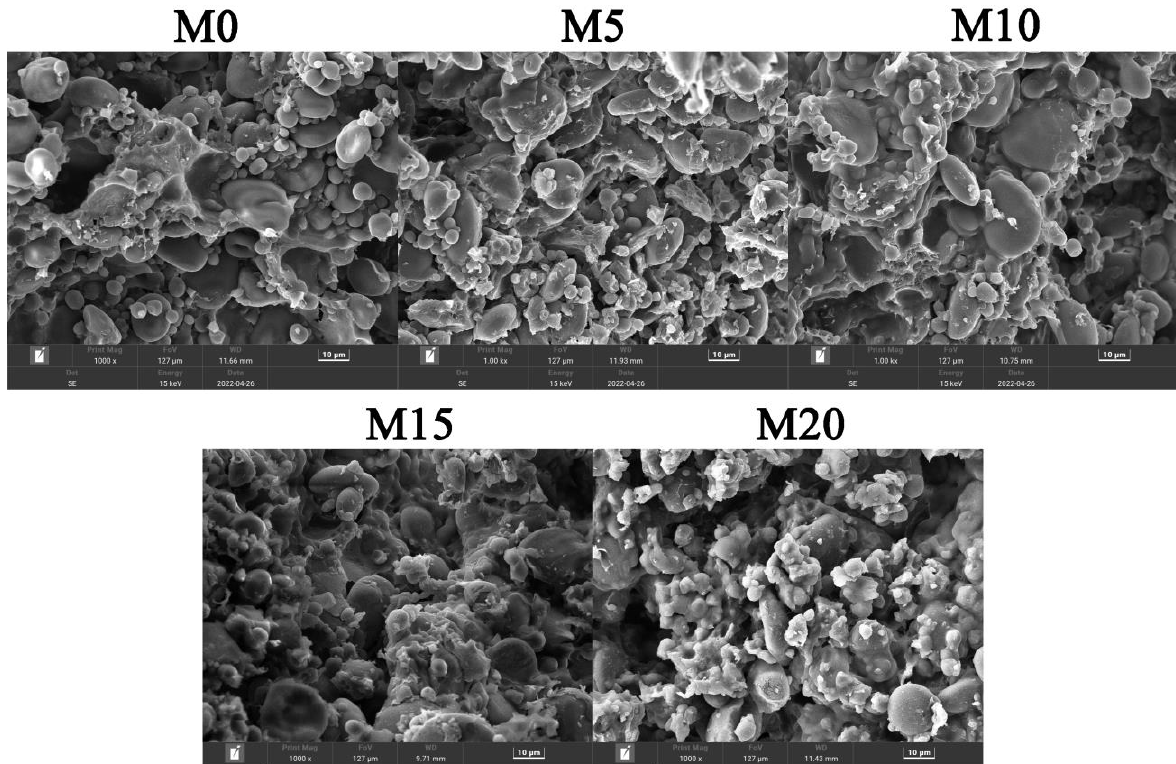
Figure 4. Representative scanning electron microscopy images of high-gluten wheat flour with 0% (M0), 5% (M5), 10% (M10), 15% (M15), and 20% (M20) mealworm powder substitution